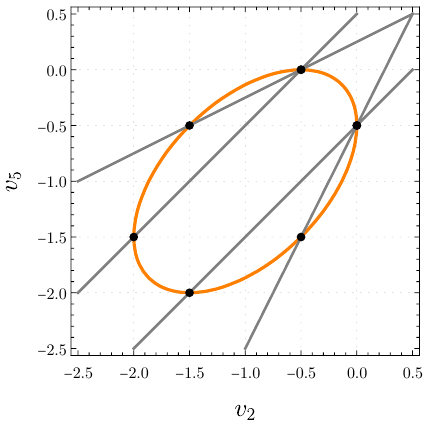
Figure 3. Section of the physical region P 0 by the plane v 1 = 3 , v 3 = v 4 = 1 . The physical region is inside the orange ellipse depicting ∆ = 0 . The four gray lines, representing a k = 0 with k = 1 , 3 , 4 , 5 (see equation (A.1)), split the surface ∆ = 0 in six arcs. The functions g (1) k = 1 , 3 , 4 , 5 , are constant on each